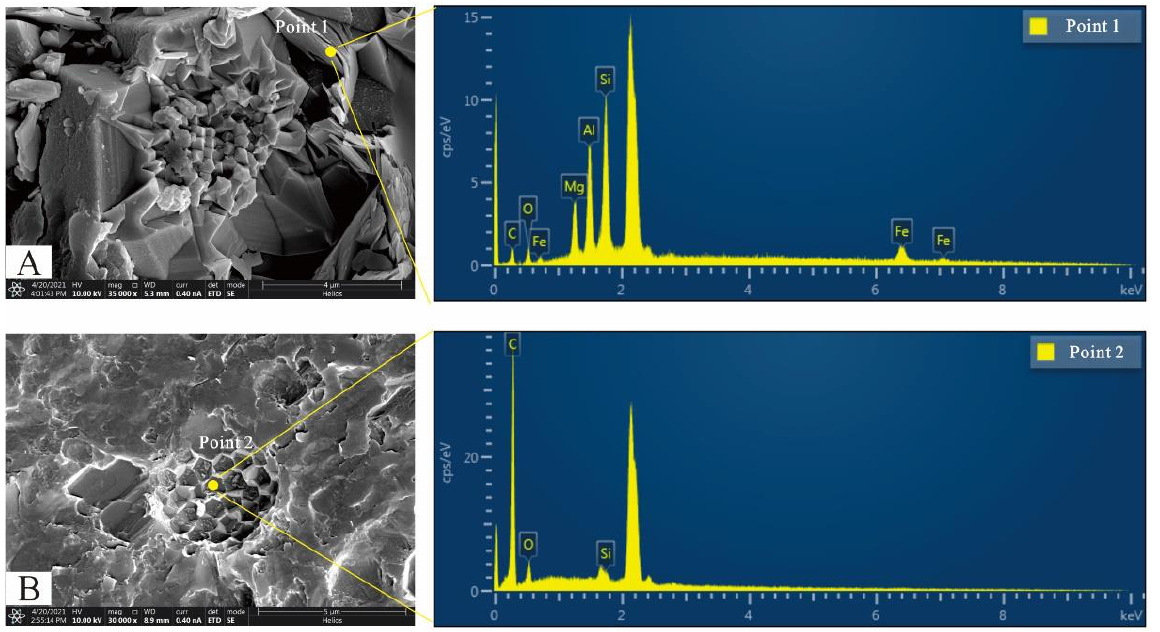
Figure 5. Energy spectrum image of graptolite shale. ( A ) The relationship between pyrite and clay minerals and energy spectrum of clay minerals. ( B ) The impression of pyrite on the graptolite epidermis and the energy spectrum of graptolite epidermis.